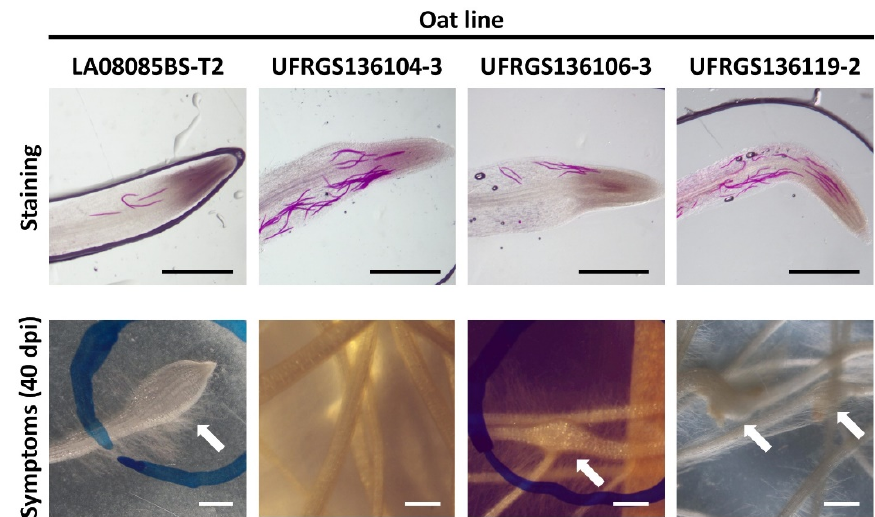
Figure 2. Penetration of M. graminicola observed by acid fuchsin staining at 24 h after inoculation and root symptoms at 40 days postinoculation (dpi): The arrow sticks indicate the swollen and horseshoe-like hooked root tips. The scale bars represent 1 mm.